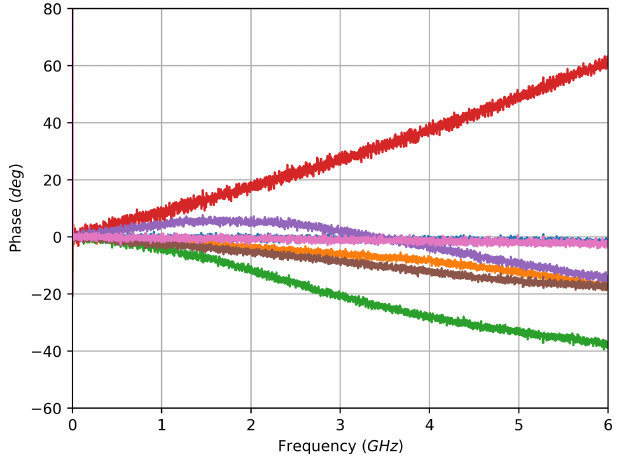
Figure 10. Electrical phase of S21 measurements of an FBG in reflection configuration.